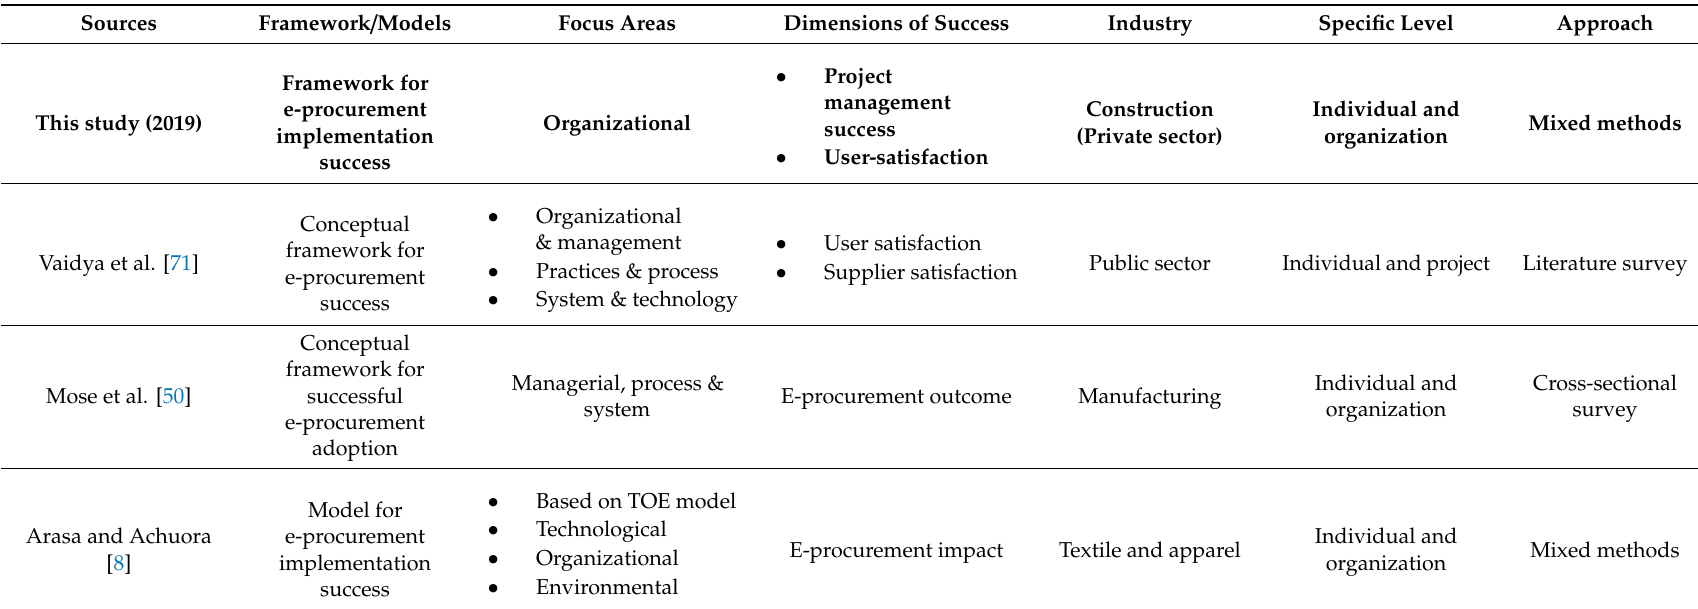
Table 7. Comparison of study